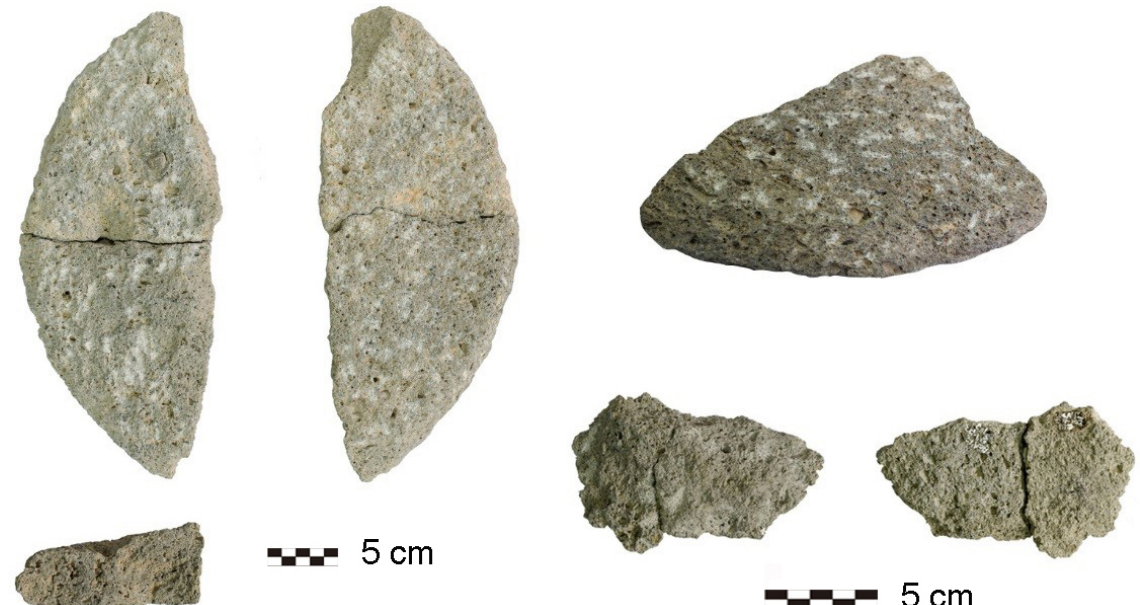
Figure 10. Evidence of rotary quern pecking. Details of elongated tool marks on rotary quern fragments and working flakes. The scale bar is 5 cm (1 cm